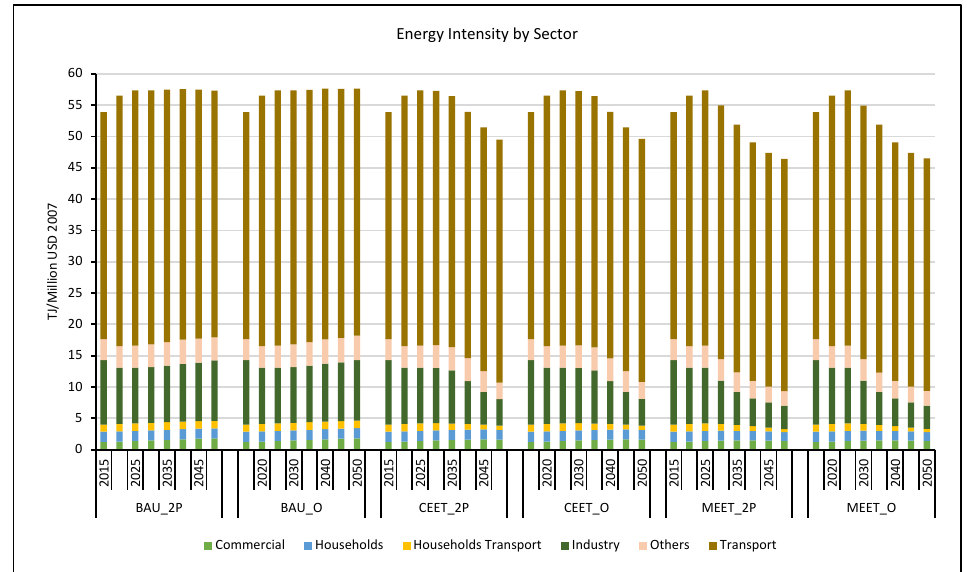
Figure 6. Evolution of energy intensity per sector and scenario.